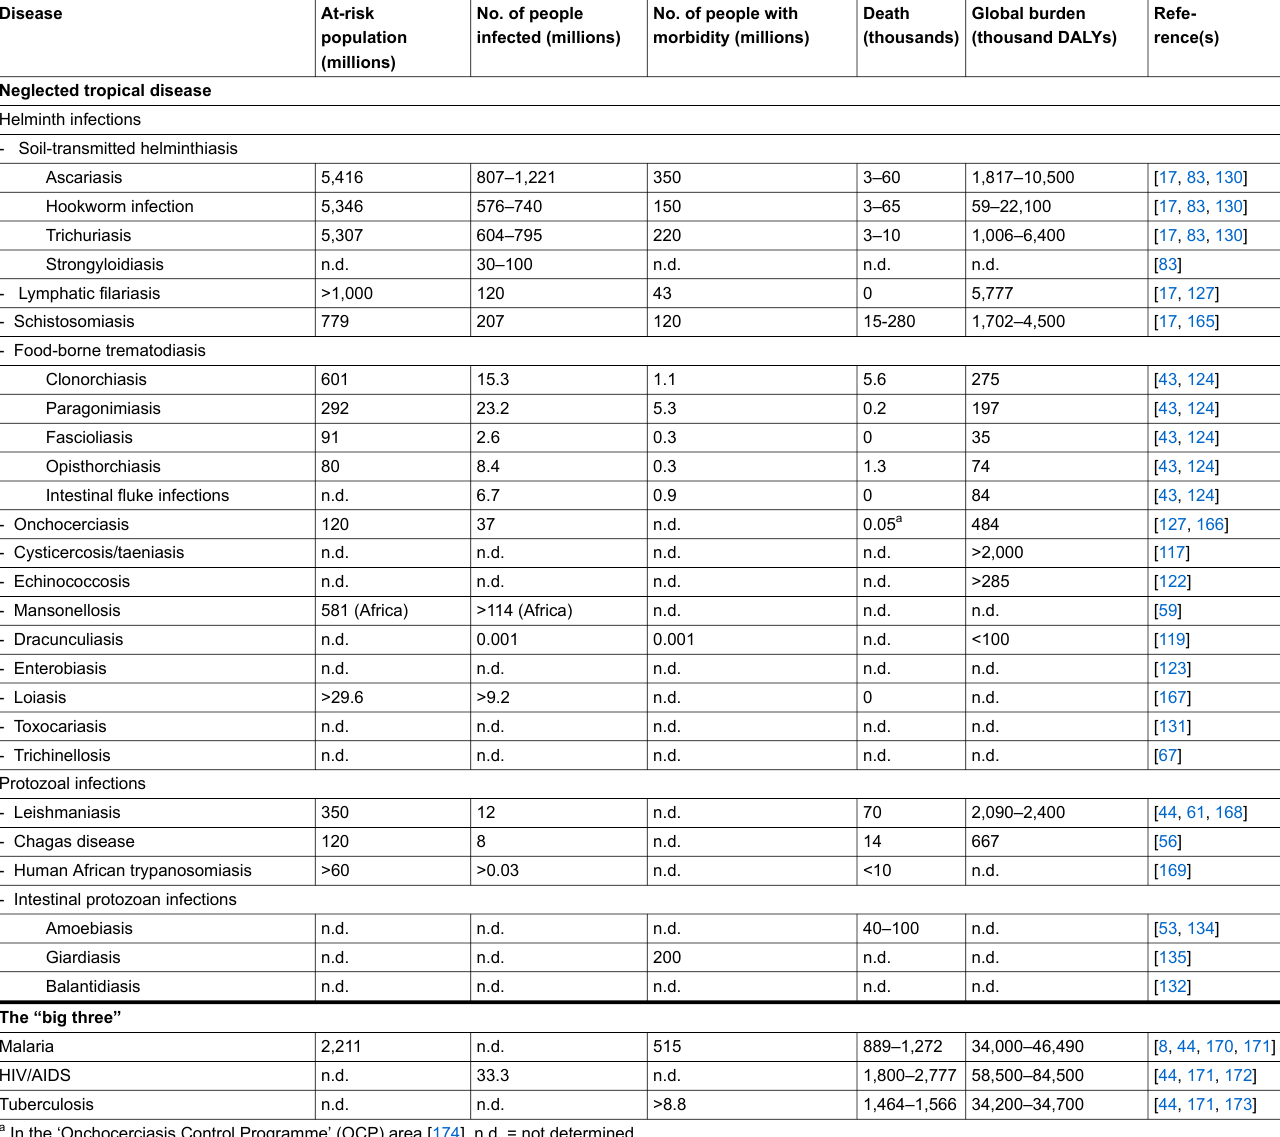
Table 2: Current estimates for the global burden due to the most important neglected tropical diseases caused by helminthic and protozoal infections. For comparison, the “big three” are also shown.